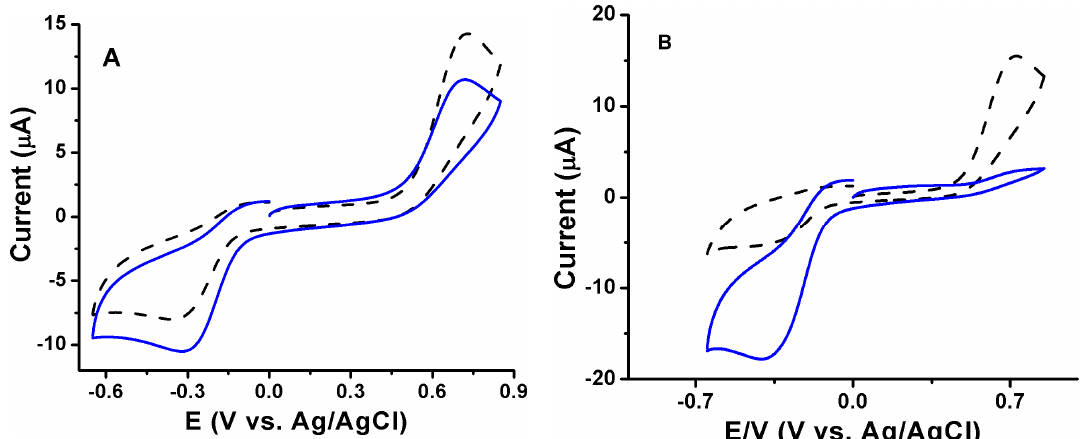
Figure 7. Cyclic voltammetric responses of serum samples recorded at 50 mV s − 1 with the proposed immunosensor in 0.05 M PBS (pH 7.4) containing freshly prepared 1 mM H 2 Q before (dashed lines) and after (solid lines) addition of 1.5 mM H 2 O 2 : ( A ) serum sample from healthy subject (sample 10691), ( B ) serum sample from celiac patient (sample 10636).